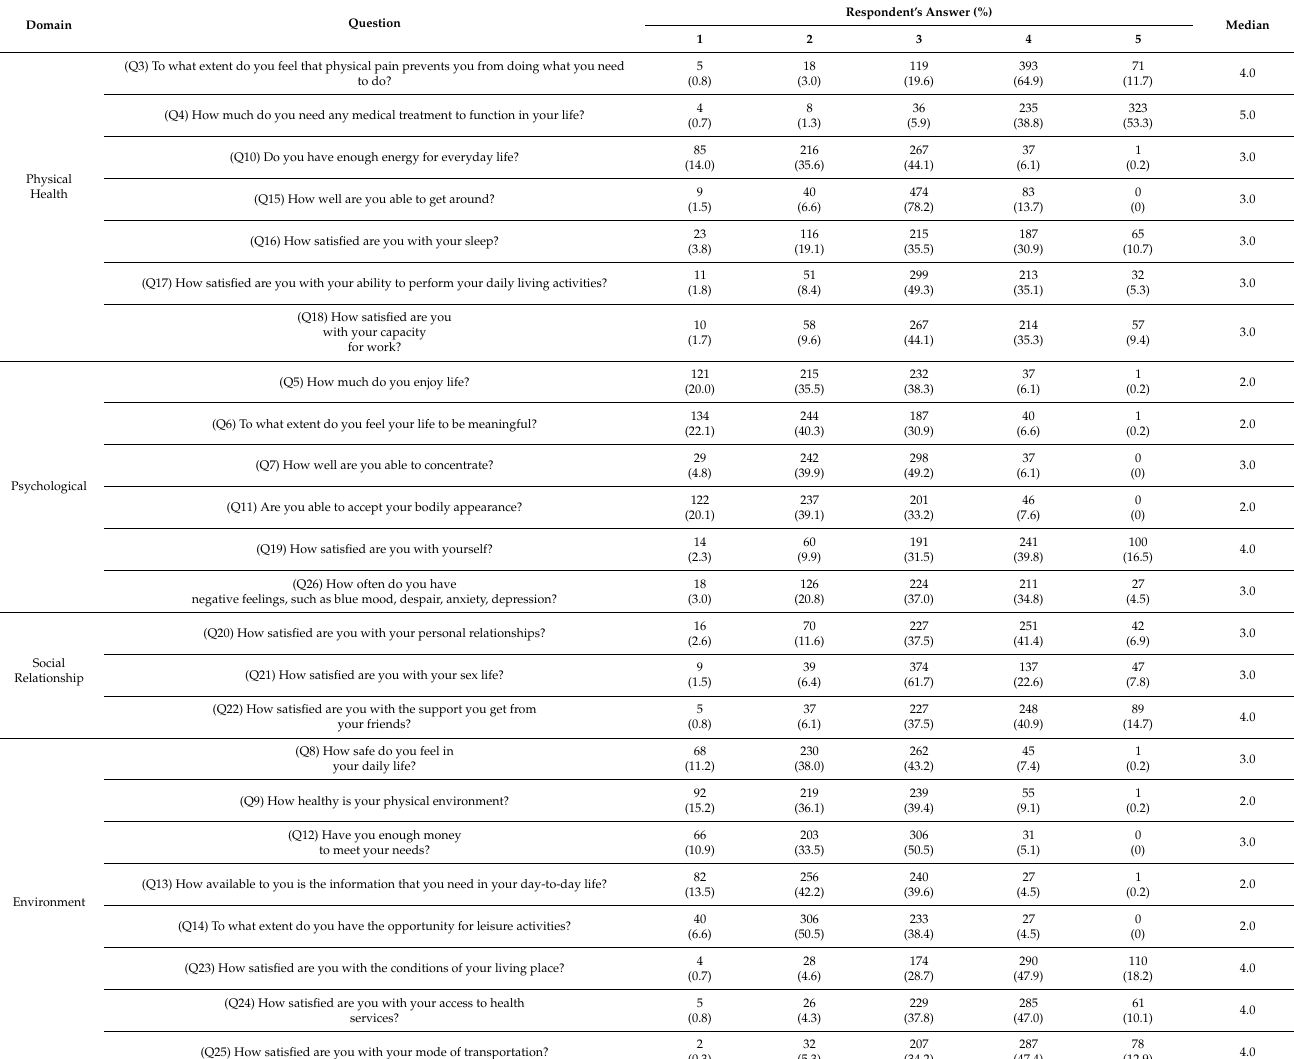
Table 5. Responses to the questionnaire on quality-of-life status (n =